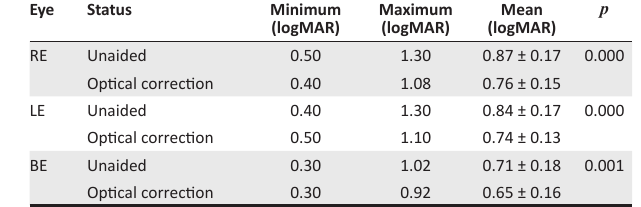
TABLE 3: LogMAR near (40 cm) without and with optical correction.